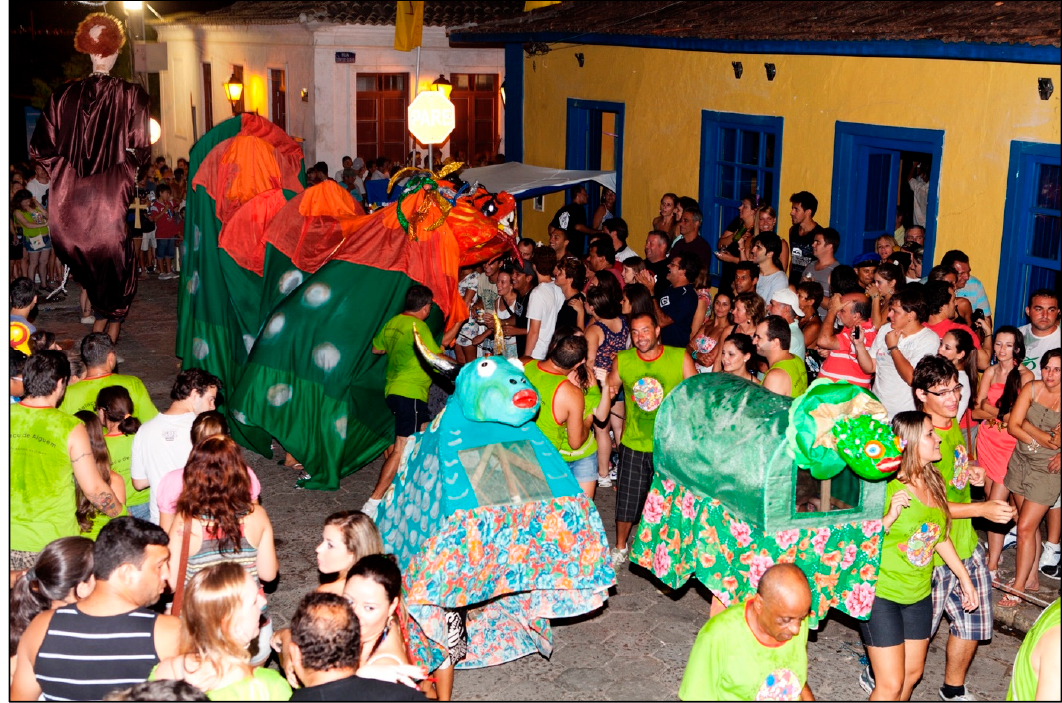
Figure 5. A view of the Florianópolis Carnival, reproduced with permission from Eduardo Zappia (photo taken in February 2018).